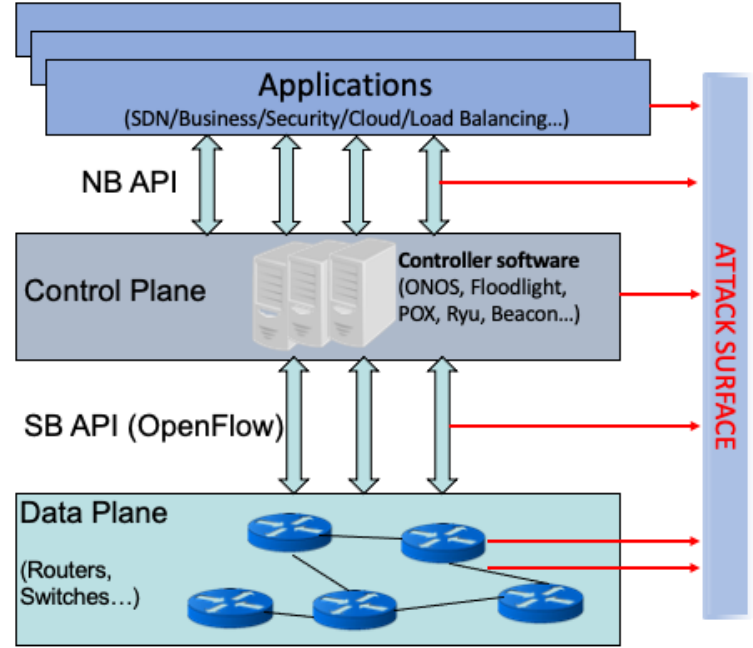
Figure 1. Software-defined networking (SDN) Architecture and Attack Surface.